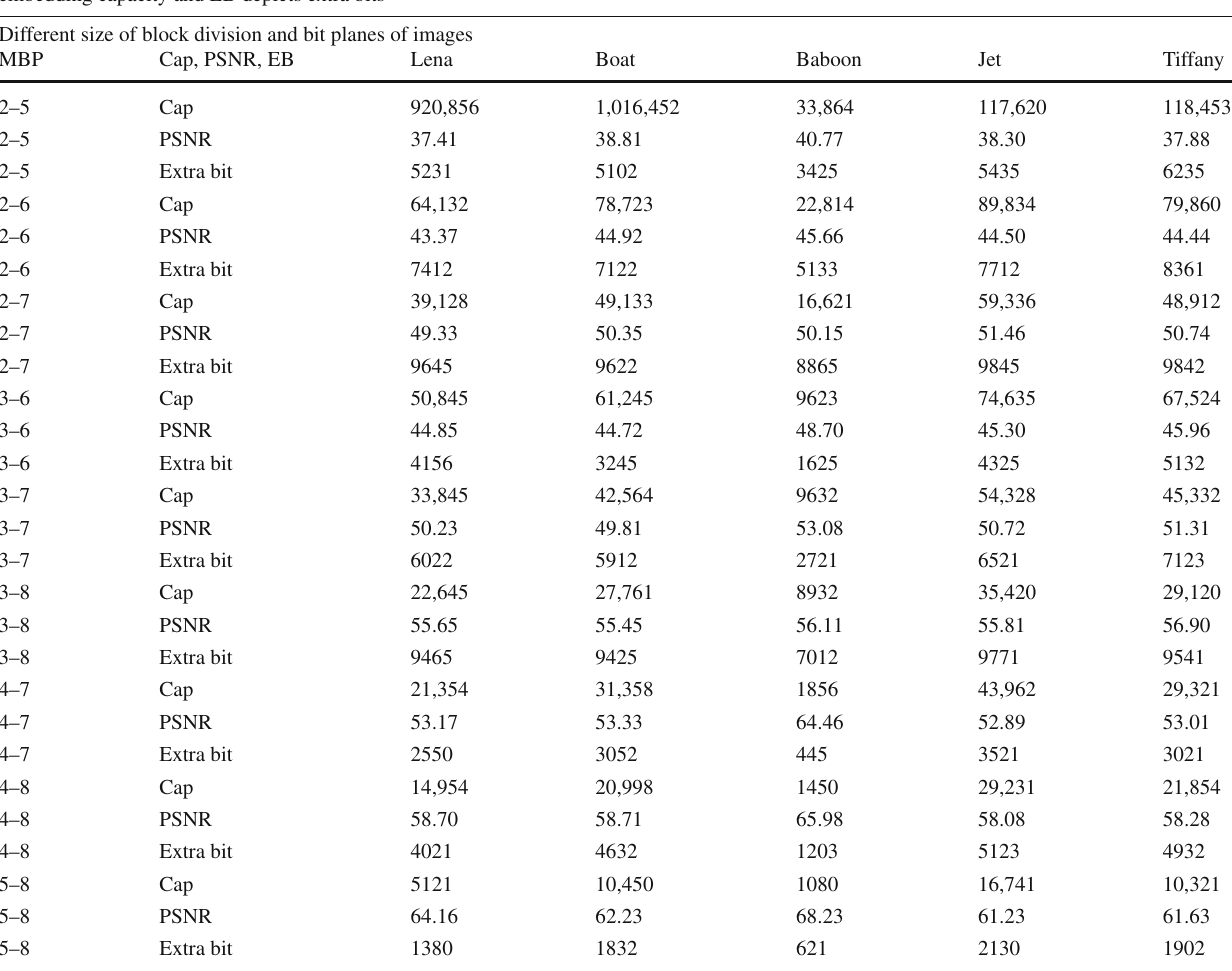
Table 2 Evaluation of the proposed scheme with different sizes of bit planes and block division; MBP signifies multiple bit planes, Cap represents embedding capacity and EB depicts extra bits Different size of block division and bit planes of images